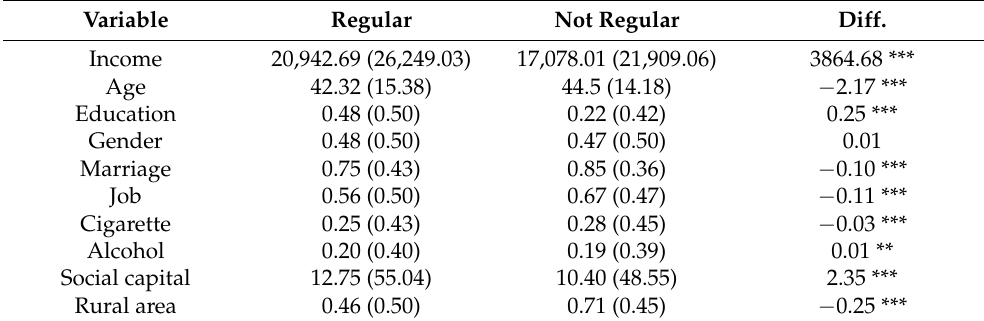
Table 2. Difference in average characteristics between regular and not regular physical activity. Variable Regular Not Regular